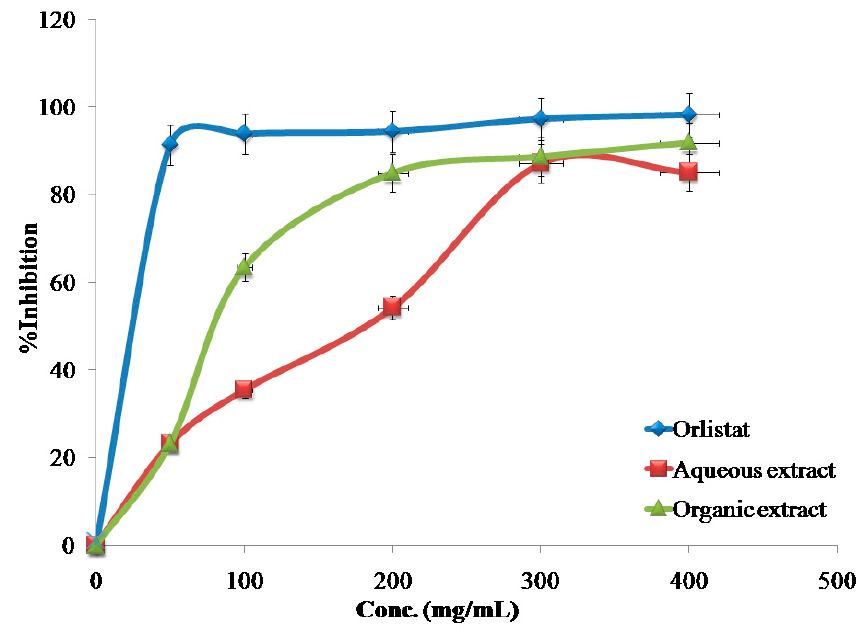
Figure 3. The inhibitory effects of the aqueous and organic extracts of C. azarolus and Orlistat on the activity of porcine pancreatic lipase.